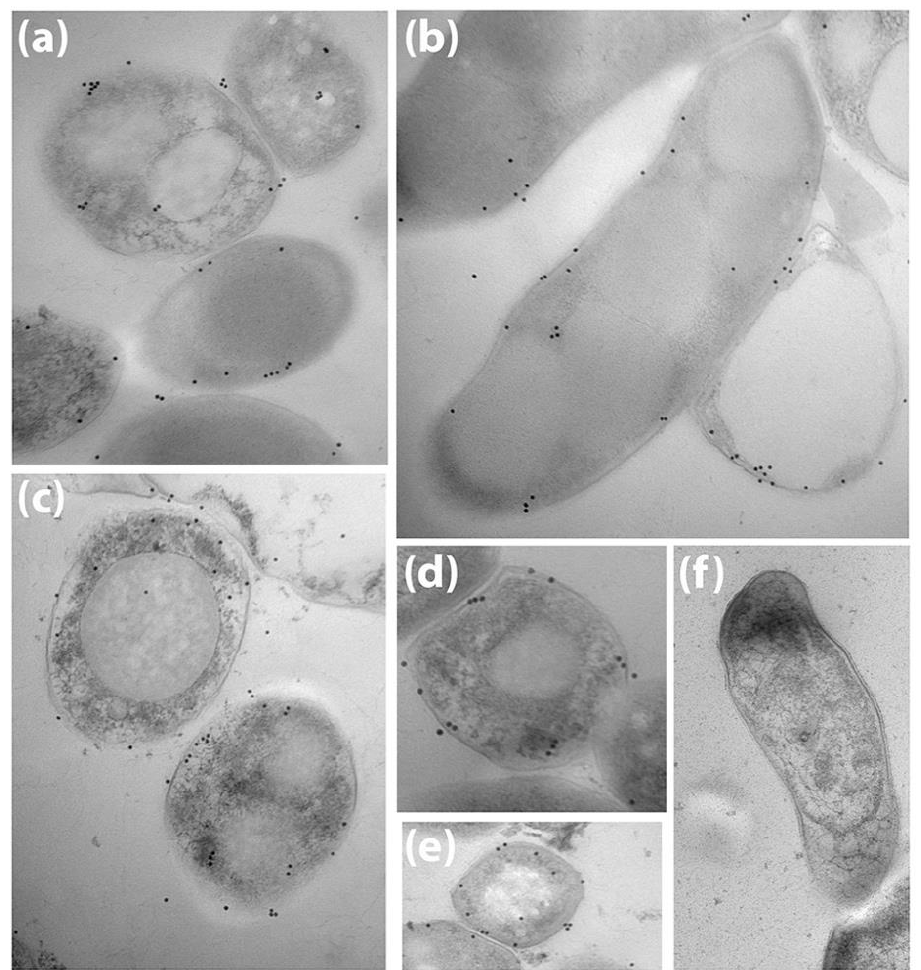
Figure 2. Transmission electron microscopy of Map K-10 exposed to rabbit pre-immune and post-immune serum. Detection of antibody binding was with Colloidal gold 10 nm particles. The images are Map strain K-10 labeled with antibody against the EtOH prep from rabbit 3993 ( a , b , and c ) and 3995 ( d and e ). Pre-immune serum from 3993 does not react to Map ( f ). Images are all magnified 49,000x.